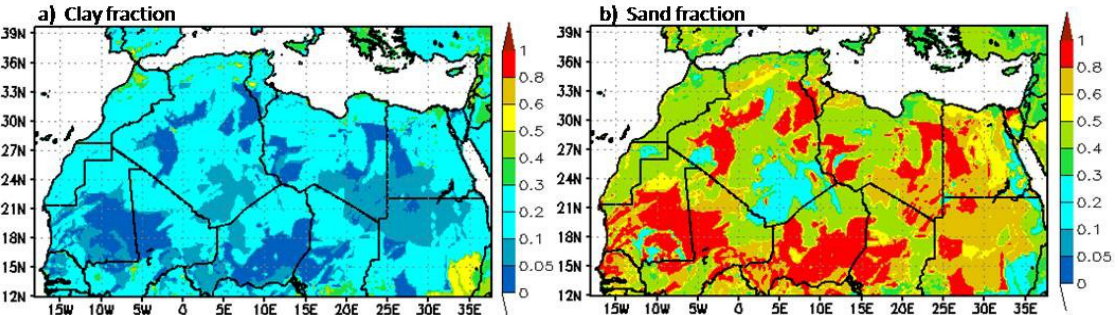
Fig. 2. Percentage of clay (a) and sand (b) for northern Africa according to FAO databases.